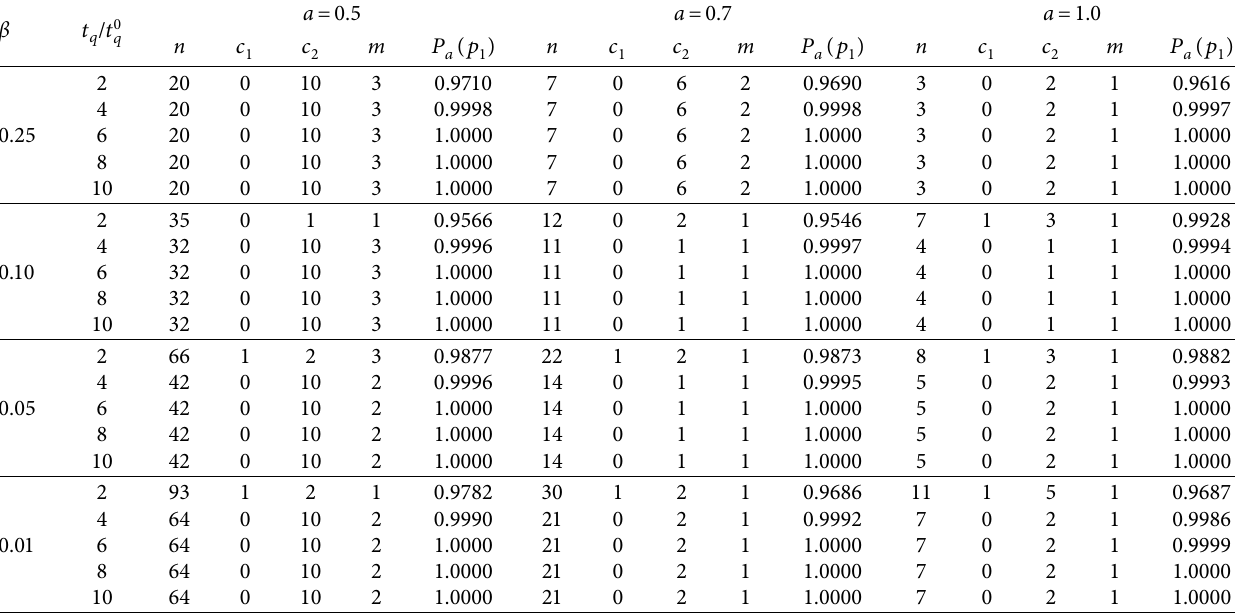
Table 1: Optimal parameters of the proposed MDSSP for EWD with δ � 2 , c � 2 at 50 th percentile.